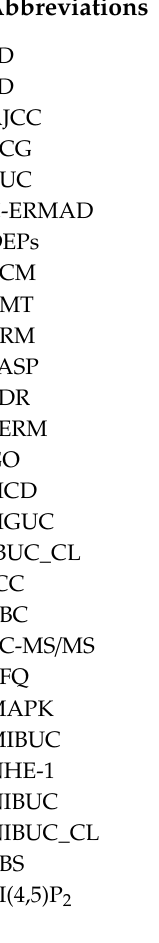
(LBC) samples), Table S2: Total list of di ff erentially expressed proteins (DEPs) by ANOVA in bladder urothelial carcinoma (BUC) (liquid-based cytology (LBC) samples), Table S3: Total list of di ff erentially expressed proteins (DEPs) by pairwise t-test in bladder urothelial carcinoma (BUC) (liquid-based cytology (LBC) samples), Table S4: Gene ontology (GO) analysis of di ff erentially expressed proteins (DEPs) in bladder urothelial carcinoma (BUC) (liquid-based cytology (LBC) samples), Table S5: Gene ontology (GO) analysis of di ff erentially expressed proteins (DEPs) with upregulation in bladder urothelial carcinoma (BUC), Table S6: Gene ontology (GO) analysis of di ff erentially expressed proteins (DEPs) with downregulation in bladder urothelial carcinoma (BUC) (liquid-based cytology (LBC) samples), Table S7: Total list of identified protein groups in tandem mass tag (TMT)-based proteomics of bladder urothelial carcinoma (BUC) cell lines, Table S8: Total list of di ff erentially expressed proteins (DEPs) in tandem mass tag (TMT)-based proteomics of bladder urothelial carcinoma (BUC) cell lines, Table S9: Comparison of di ff erentially expressed proteins (DEPs) between proteomics of liquid-based cytology (LBC) samples of bladder urothelial carcinoma (BUC) and tandem mass tag (TMT)-based proteomics of BUC cell lines, Table S10: Correlation between MSN RNA expression and AJCC staging and angiolymphatic invasion in bladder urothelial carcinoma (BUC) in The Cancer Genome Atlas (TCGA) public